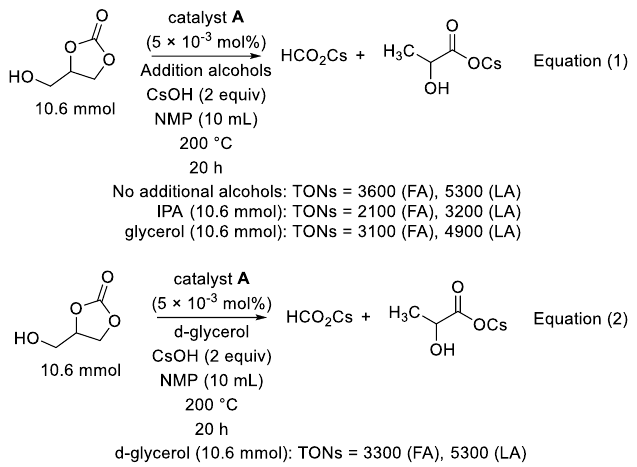
Scheme 3. Reaction of GC in the presence of additional alcohols.